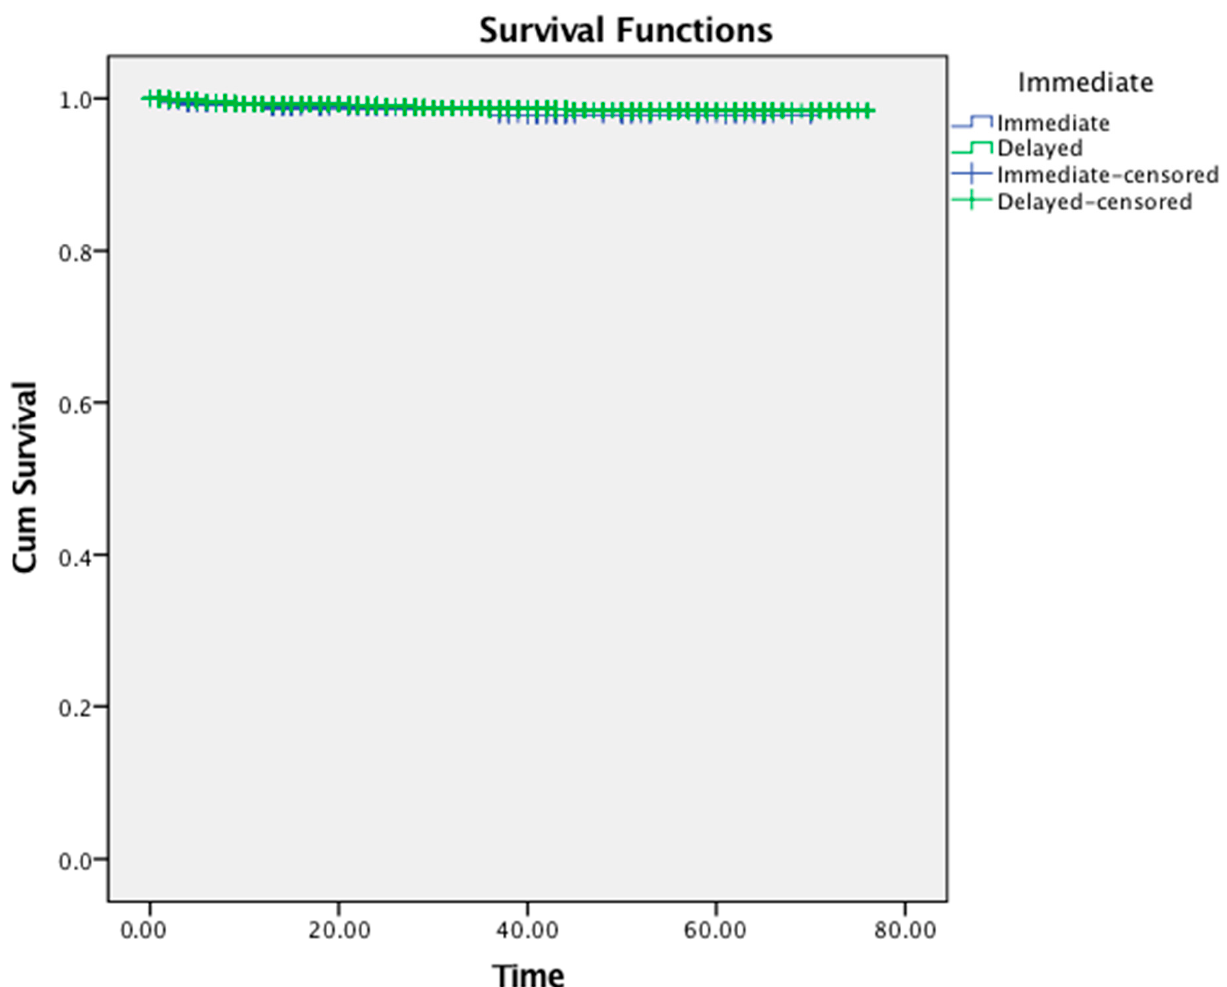
Figure 1. Kaplan–Meier curve showing the cumulative survival rates of immediate and delayed implant treatment to time (in months).